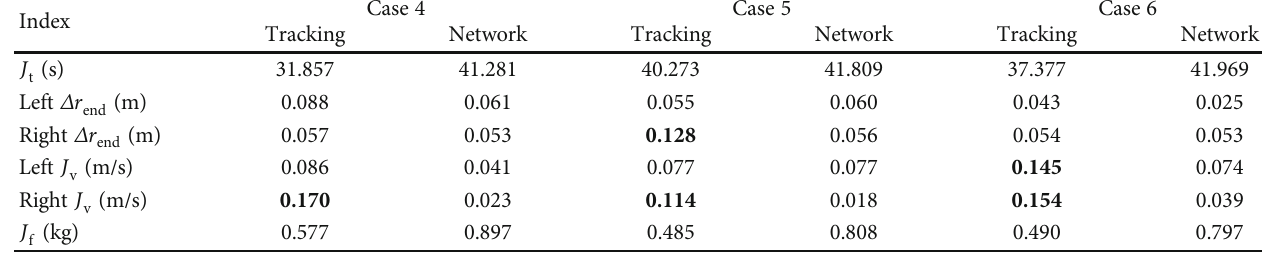
Table 7: Simulation results for the latter three veri fi cation cases.